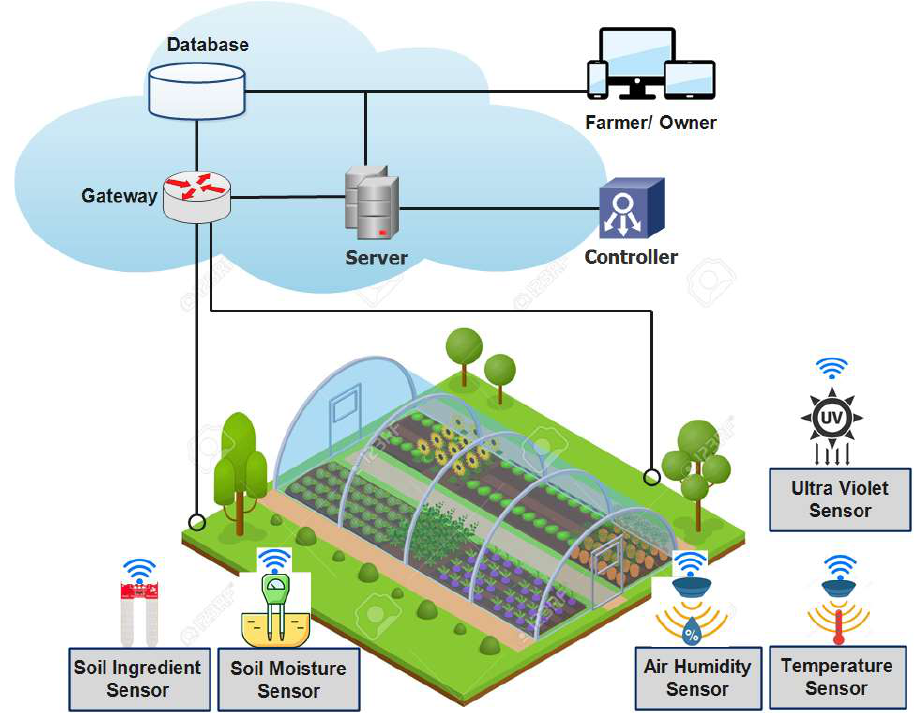
Figure 7. An illustration of IoT application for monitoring farming conditions in a greenhouse.